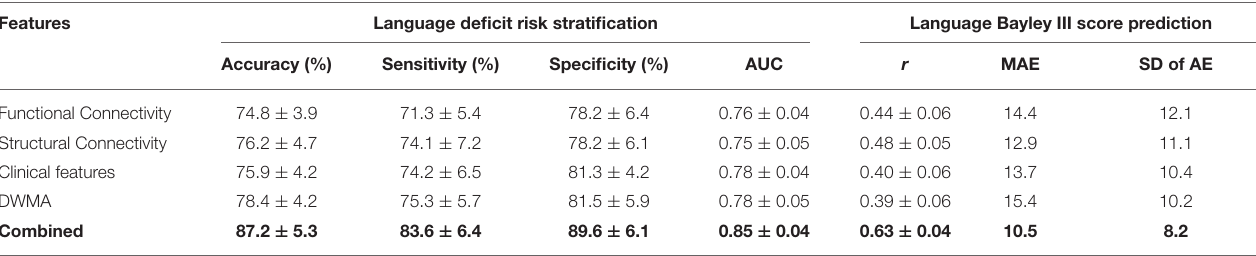
TABLE 6 | Performance comparison shows that our proposed deep multimodal learning model using combined feature sets (i.e., functional connectome + structural connectome + clinical data + DWMA) obtained at term-equivalent age outperforms each individual feature set for early identification of very preterm infants at high-risk for motor deficits and predicting their actual Bayley III Motor scores at 2 years corrected age.